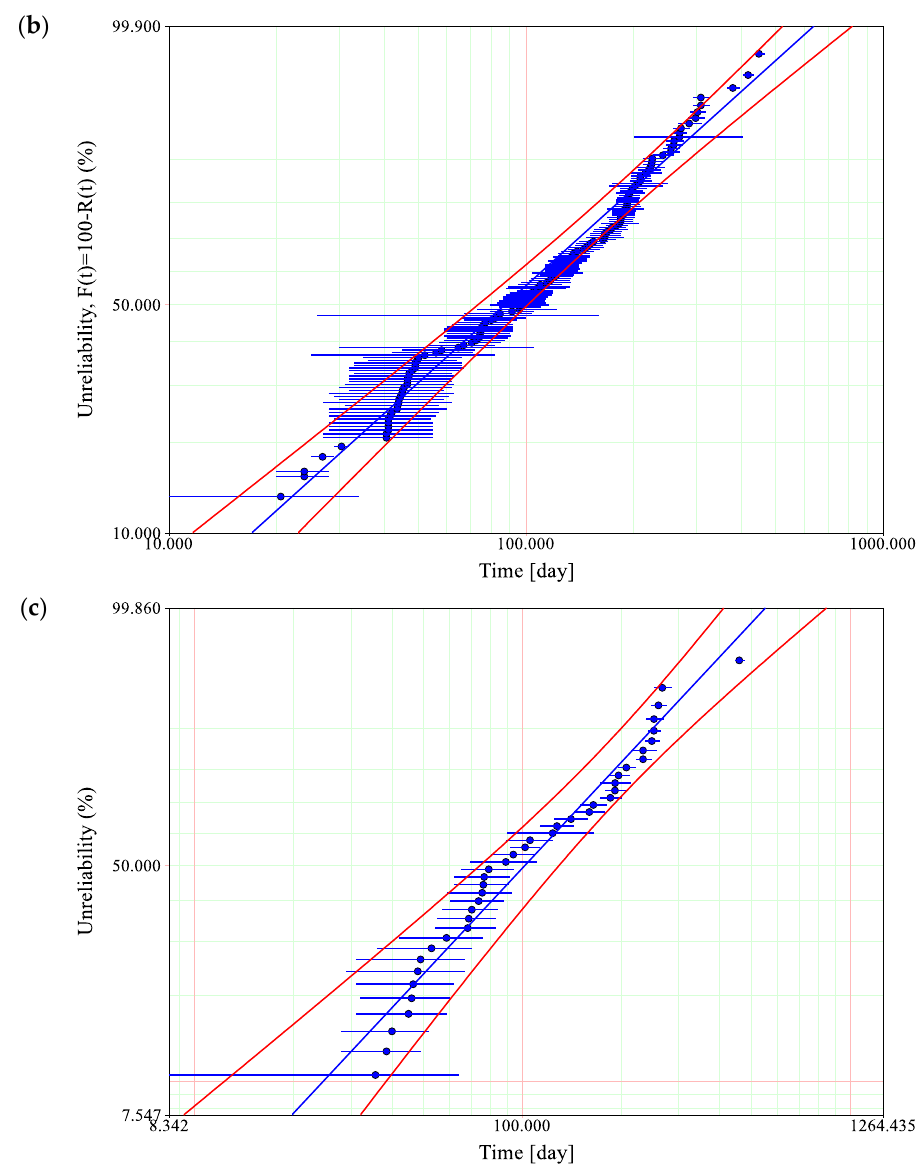
Figure 6. Weibull probability plots for the selected types of pantograph: ( a ) DSA-150; ( b ) AKP-4E; and ( c ) 5-ZL.